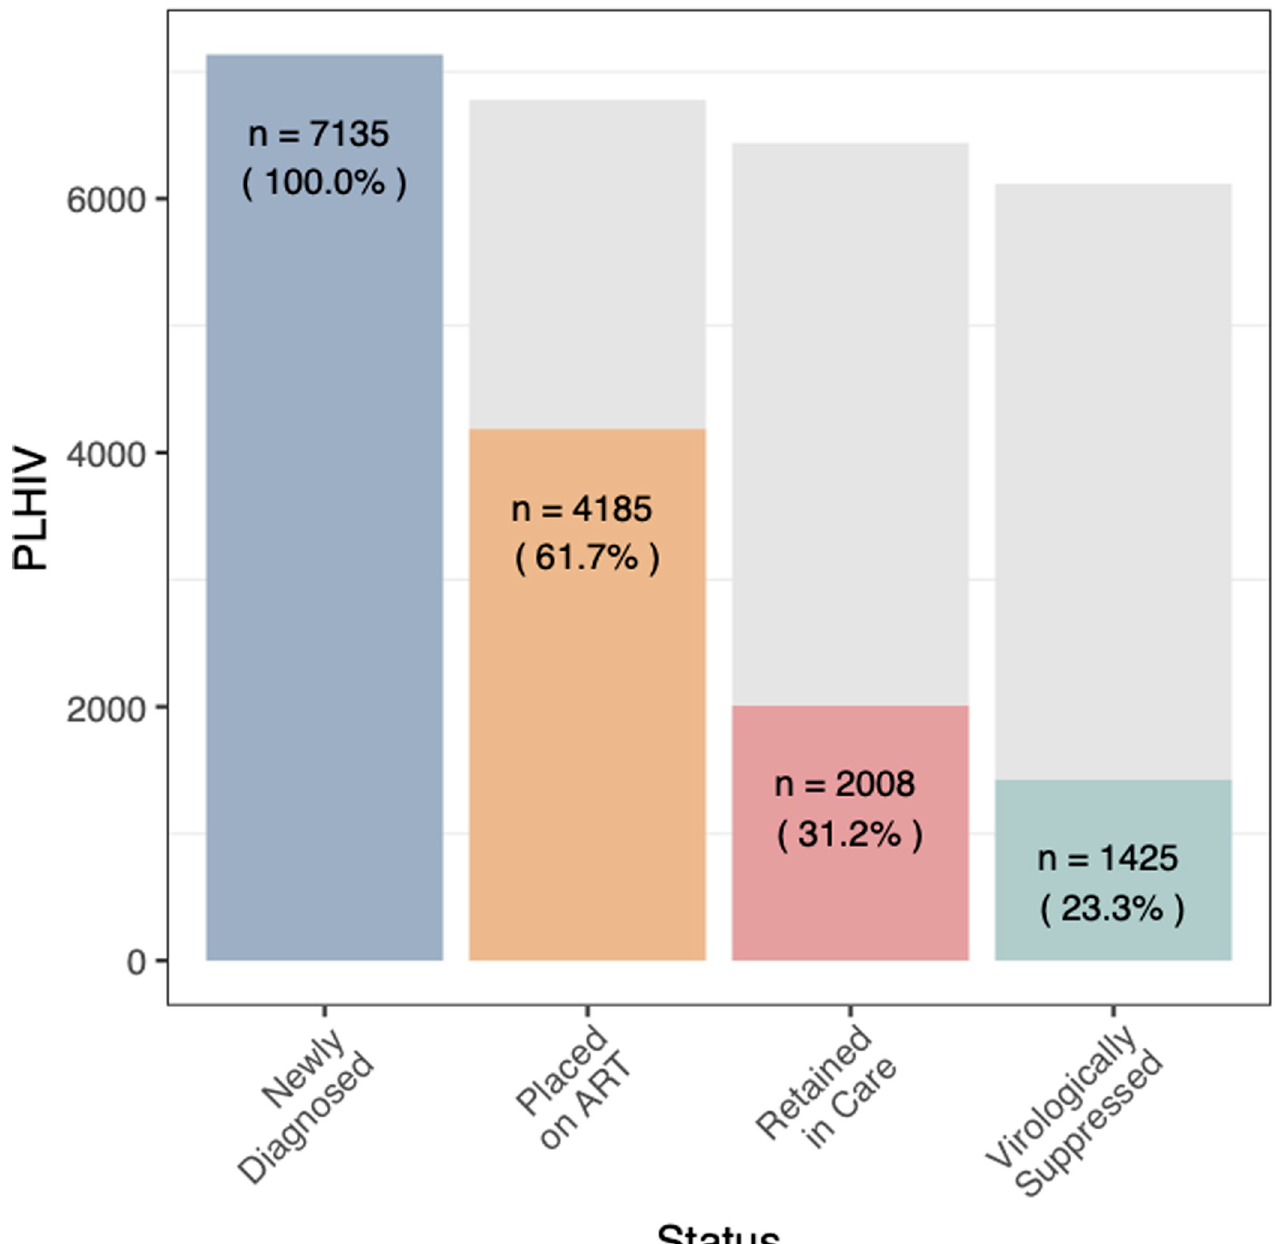
Fig 2. HIV care cascade during 24 months of follow up for individuals registered in care during 2016 and 2017 across 28 facilities in Liberia. Blue bar- represents the total number of people diagnosed with HIV, 15 years and older, across the 28 health facilities as reported by the District Health Information System 2 (DHIS2); amber–represents the total number of eligible patients registered for care and treatment services at the 28 facilities; red–represents retention and the key outcomes of patients in care and treatment after 24 months of follow up; green–represents the number of patients evaluated for viremia among patients retained in care; gray–represents the gap along each stage of the care